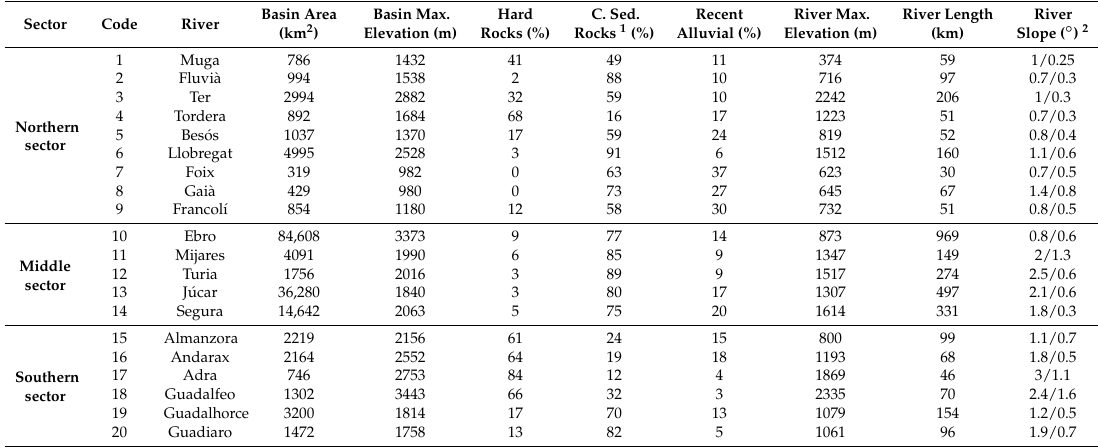
Table 3. Geomorphologic and geologic characteristics of the studied rivers.